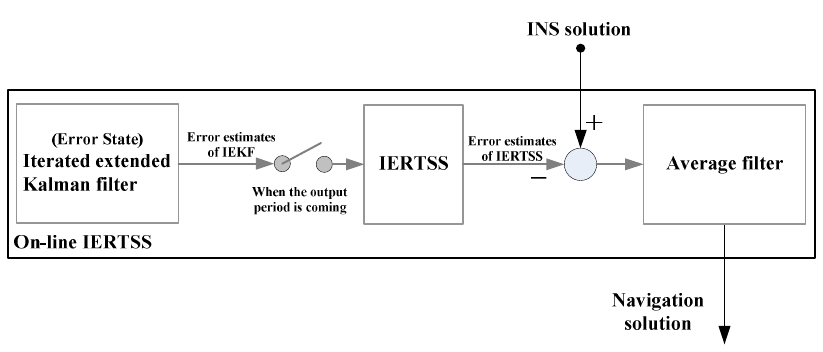
Figure 1. The flow chart of the on-line